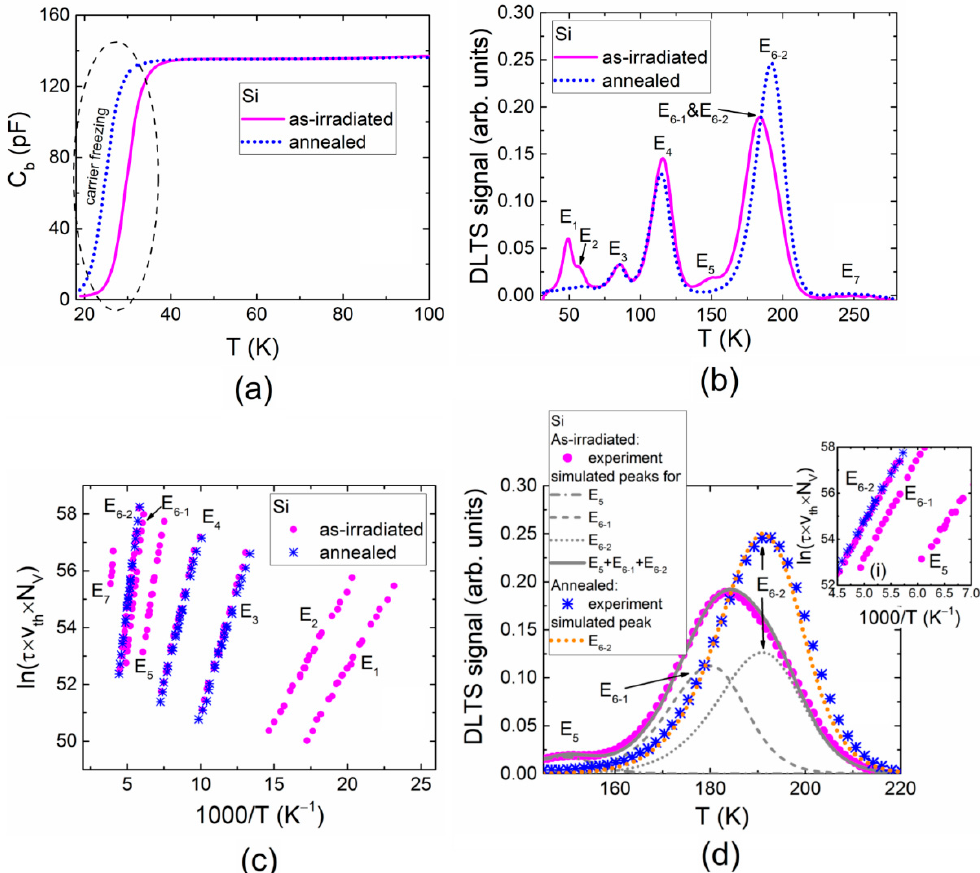
Figure 1. ( a ) The barrier capacitance dependence on temperature (C b –T) obtained for 5.5 MeV electron irradiated and subsequently annealed Si samples. ( b ) Deep-level transient (DLT) spectra of the as-irradiated and annealed Si samples. ( c ) Arrhenius plots made for different traps. ( d ) The highlighted spectral range inherent for the E 5 , E 6-1 and E 6-2 trap appearances. Inset (i) Arrhenius plots for traps E 6-1 and E 6-2 . Here, τ denotes the carrier lifetime relative to emission; υ th is the carrier thermal velocity, and N V stands for the effective density of hole states in the valence band.